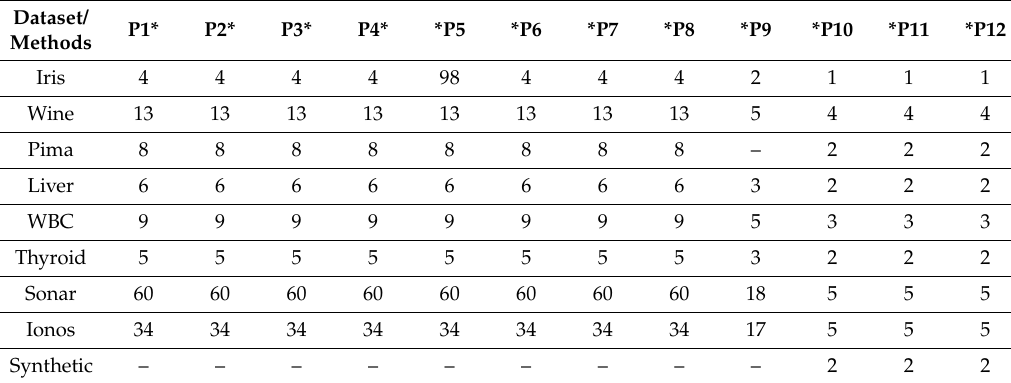
Table 9. Number of features used under some other